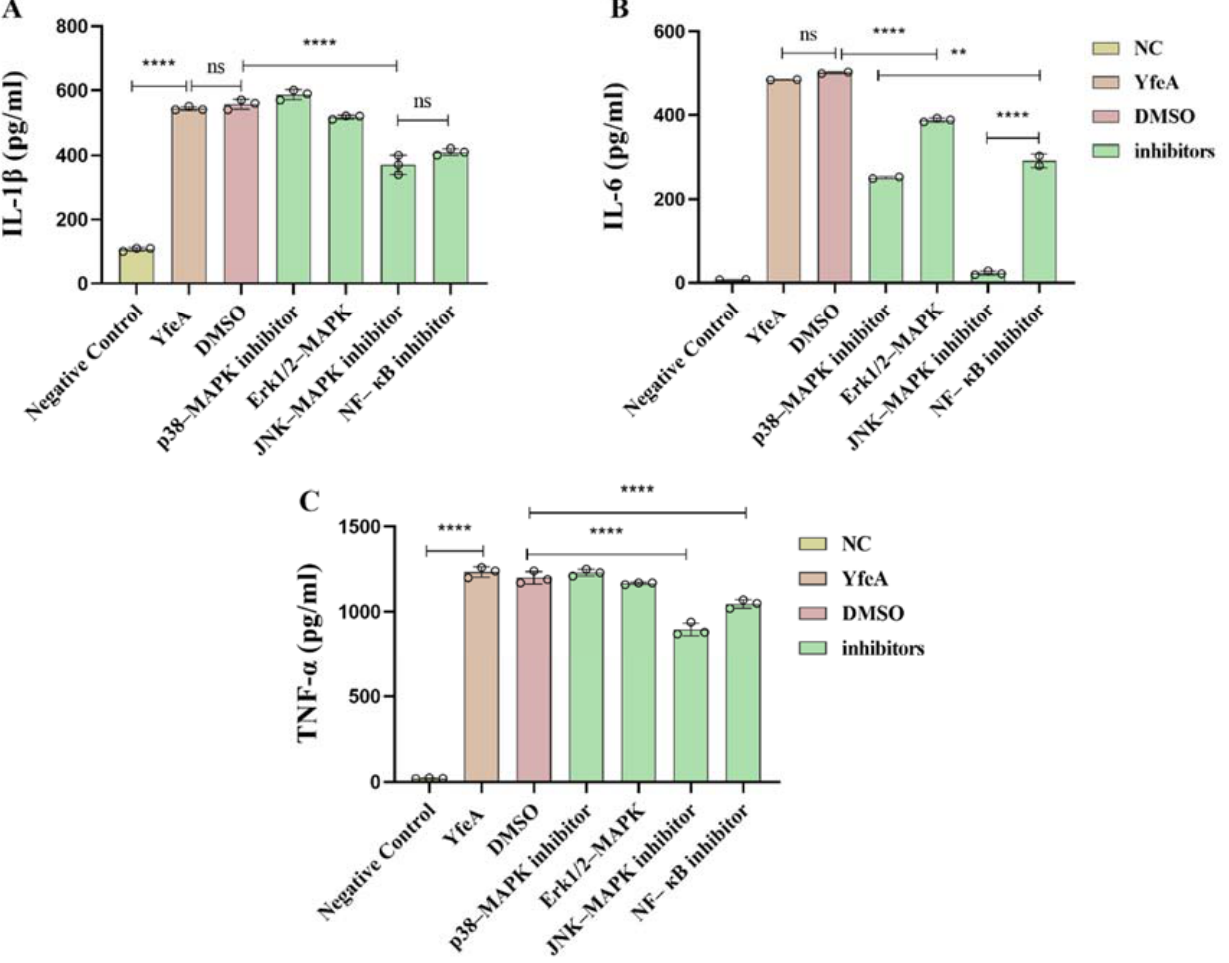
Figure 9. Effects of inhibitor on the pro-inflammatory cytokine secretion induced by YfeA. RAW Figure 9 . Effects of inhibitor on the pro ‐ inflammatory cytokine secretion induced by YfeA. RAW 264.7 were plated into 6-well plates at a density of 2 × 10 6 cells/well overnight, then SB203580 264.7 were plated into 6 ‐ well plates at a density of 2 × 10 6 cells/well overnight, then SB203580 (p38 ‐ MAPK inhibitor), U0126 (Erk1/2 inhibitor), SP600125 (JNK inhibitor), and PDTC (NF ‐κ B inhibitor) were used to block their corresponding MAPK and NF ‐κ B signal pathways. Secretion levels of IL ‐ 1 β ( A ), IL ‐ 6 ( B ), and TNF ‐α ( C ) in the culture supernatants were determined by ELISA. Significant differences between groups are indicated by ** p < 0.01 and **** p < 0.0001, ns p < 0.05.